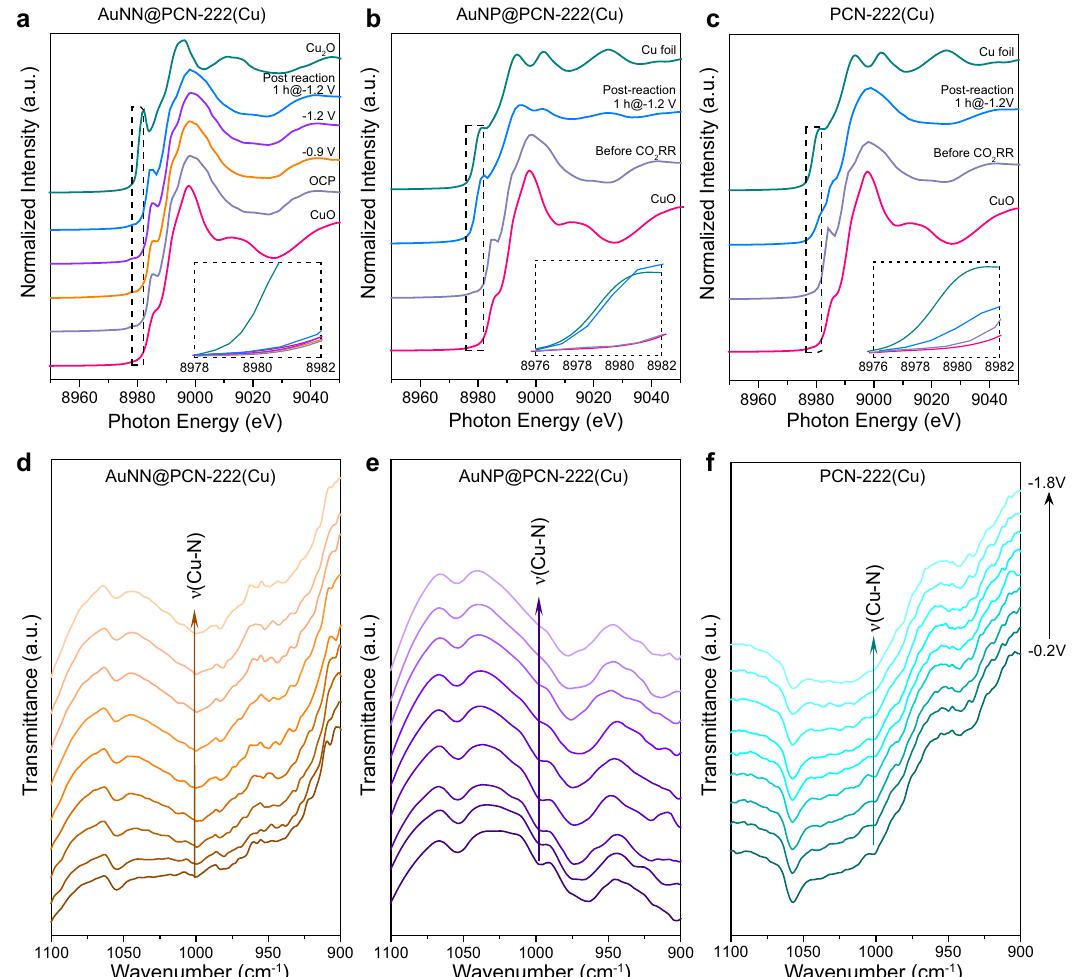
Fig. 5 XANES and IR characterizations on the structural stability of catalysts. a Operando Cu K-edge XANES spectra taken on AuNN@PCN-222(Cu) at varying potentials and after 1 h CO 2 RR test at − 1.2 V. b,c Cu K-edge XANES spectra acquired on AuNP@PCN-222(Cu) and PCN-222(Cu) before and